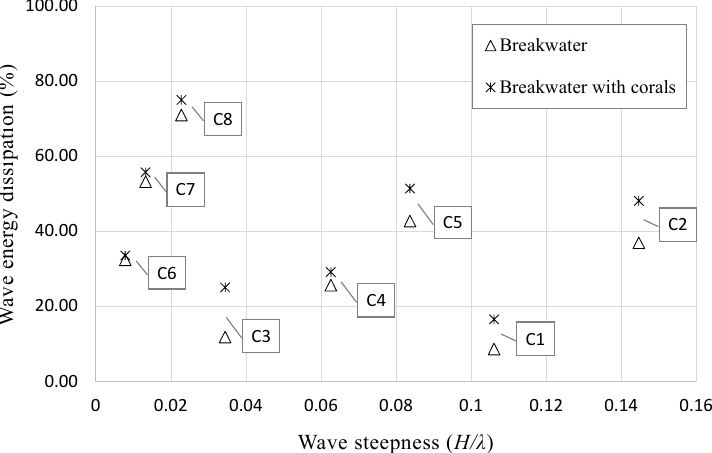
Figure 9. Wave-energy dissipation for the two configurations of the reef model under a water depth h = 0.75 m.